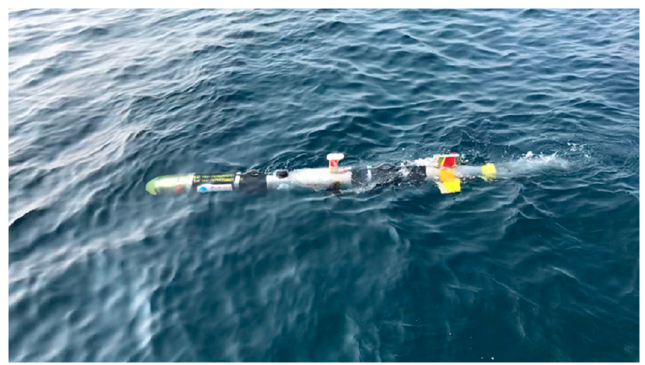
Figure 5. Experiment scene of AUV platform.